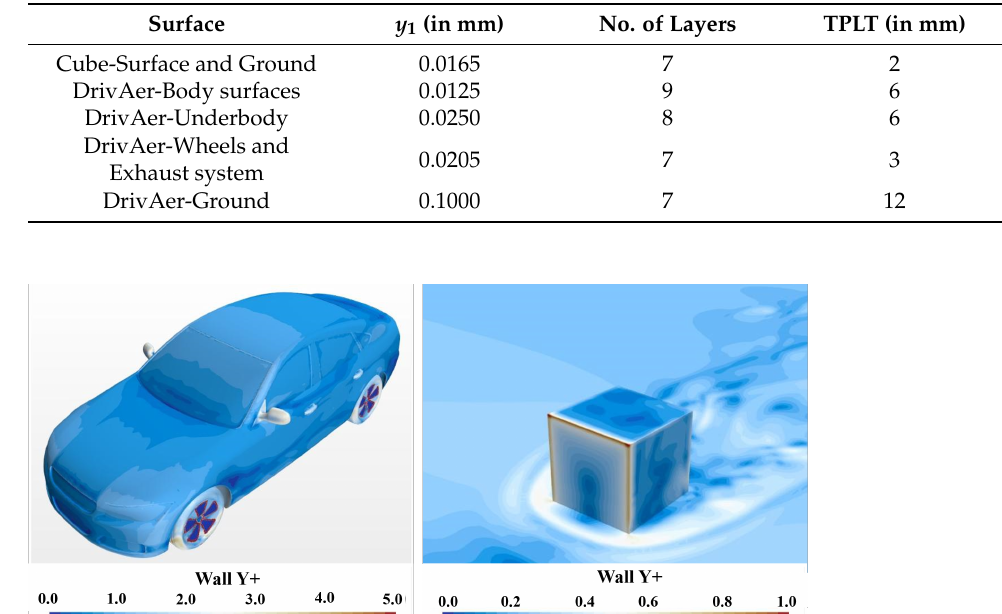
Table 2. Prism layer meshing details for both the surface mounted cube and DrivAer models.